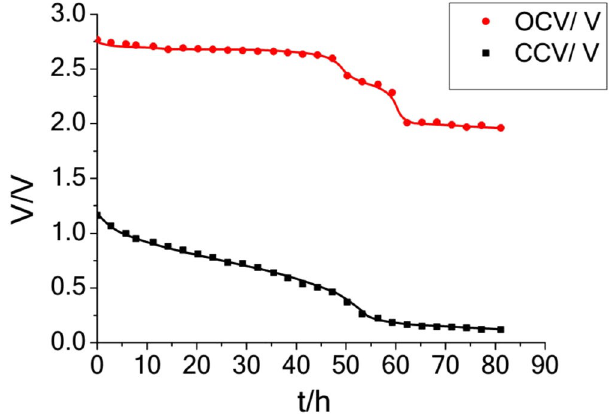
Figure 2. Open-circuit voltage (OCV) and closed-circuit voltage (CCV) profiles 11